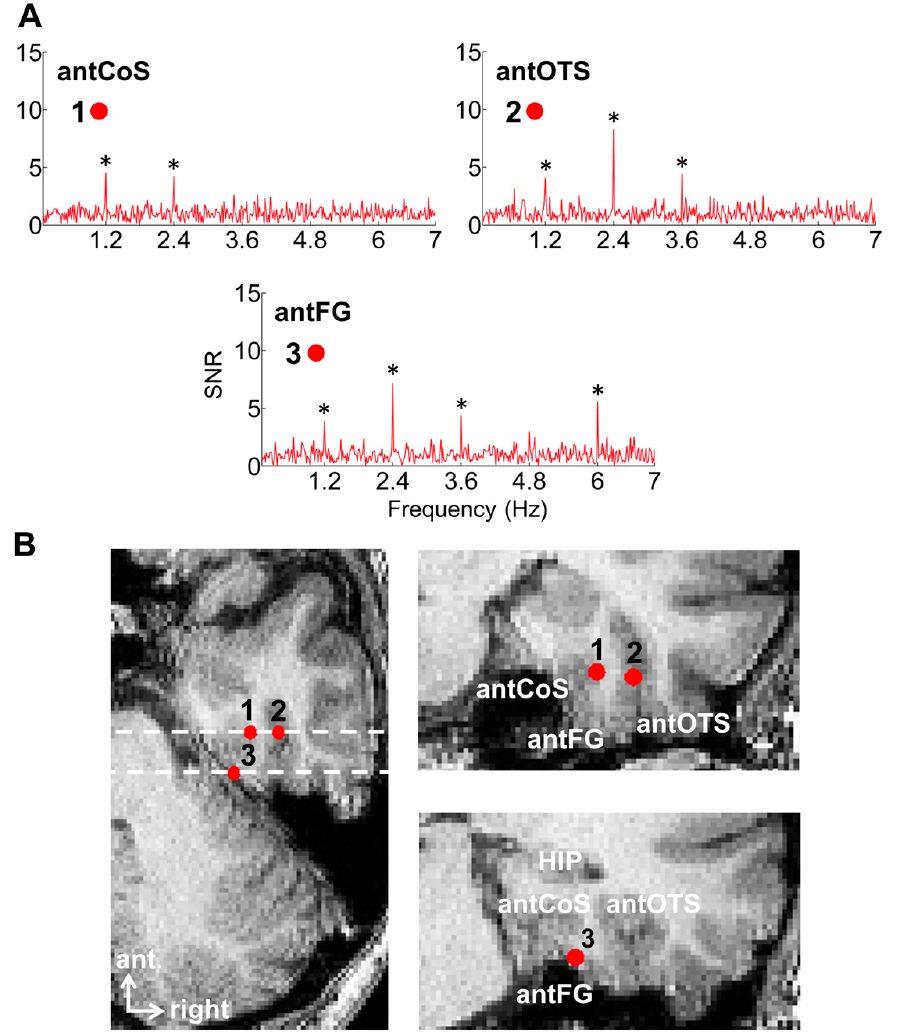
Figure 8. Example of face-selective responses in three distinct anatomical regions of the ventral ATL (from Jonas et al., 2016 [60]). ( A ) Face-selective responses were recorded from the right antCoS, antOTS, and antFG in a single brain. Note that in the examples shown here for the antCoS and antOTS, no general visual responses were recorded at 6 Hz and harmonics (“face-exclusive” responses). * Statistically significant responses (Z > 3.1, p < 0.001). ( B ) Anatomical locations of corresponding recording contacts on MRI slices. Contacts are shown as red dots on axial ( left panel) and coronal ( right panel) slices. White dashed lines over the axial view ( left panel) show the location of the two coronal slices ( right panel). Electrode contacts 1, 2, and 3 are, respectively, located in the antCoS, antOTS, and antFG. The antFG is located between the antCoS and antOTS at a level where the hippocampus (HIP) is visible on a coronal